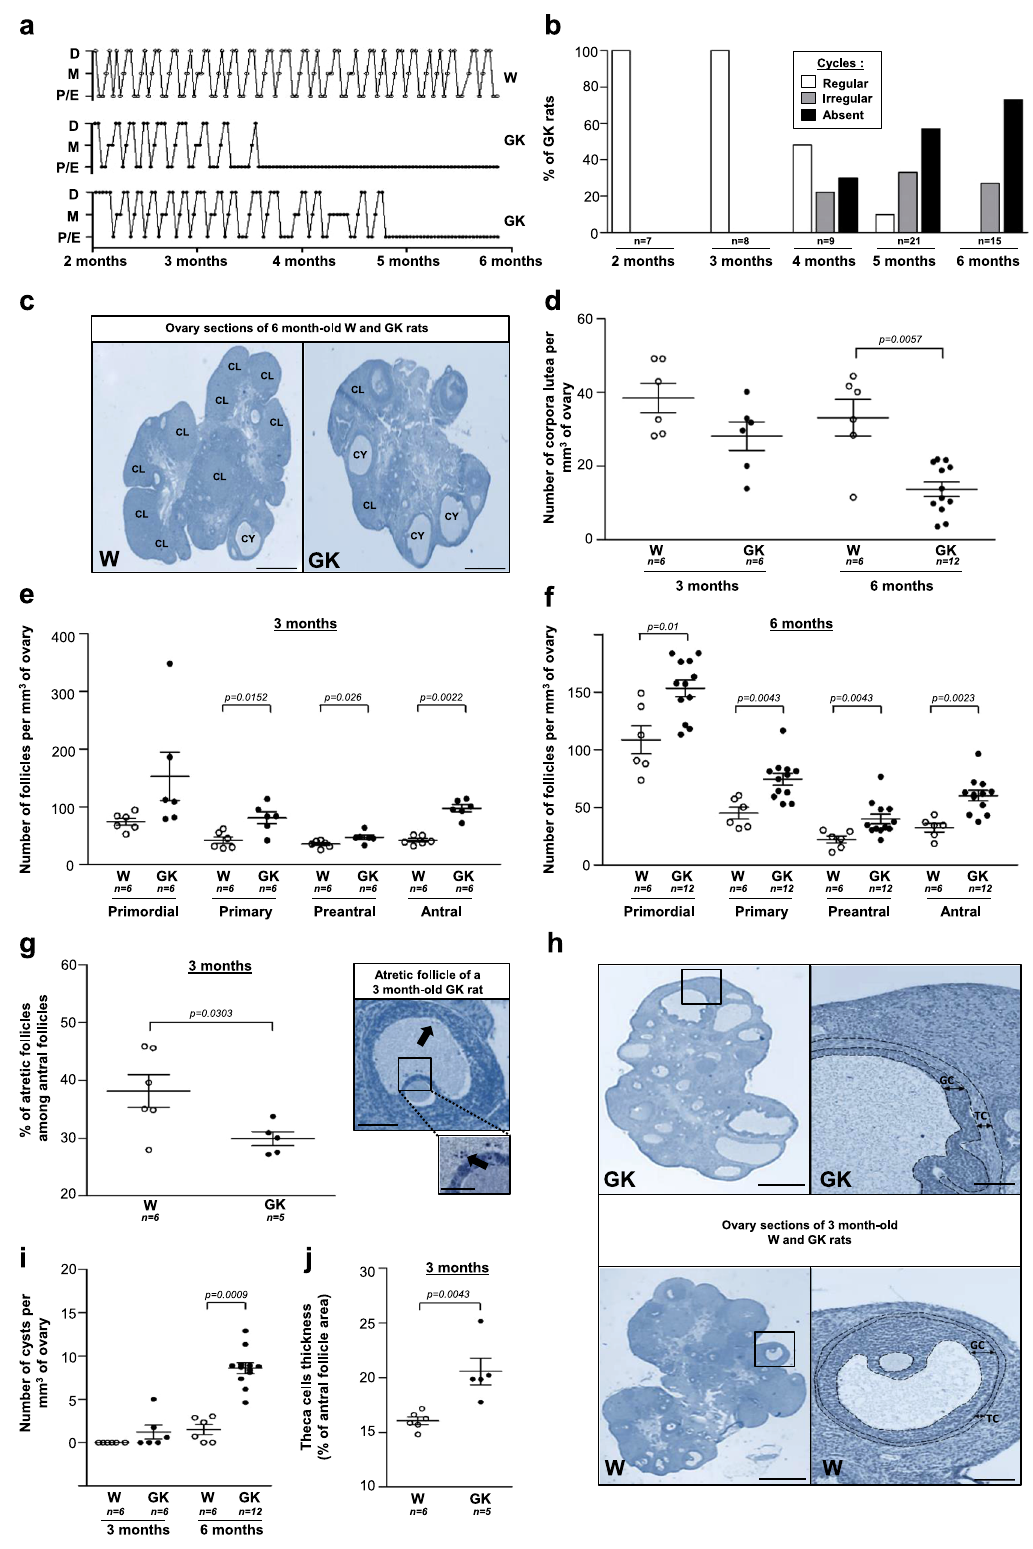
(Fig. 4c). At 3 months, there was no evidence for a difference between the progesterone levels of GK rats and Wistar controls, whereas at 6 months progesterone levels decreased in GK rats, which is consistent with their oligo/anovulation. There was no evidence for a difference in the estradiol levels between GK and